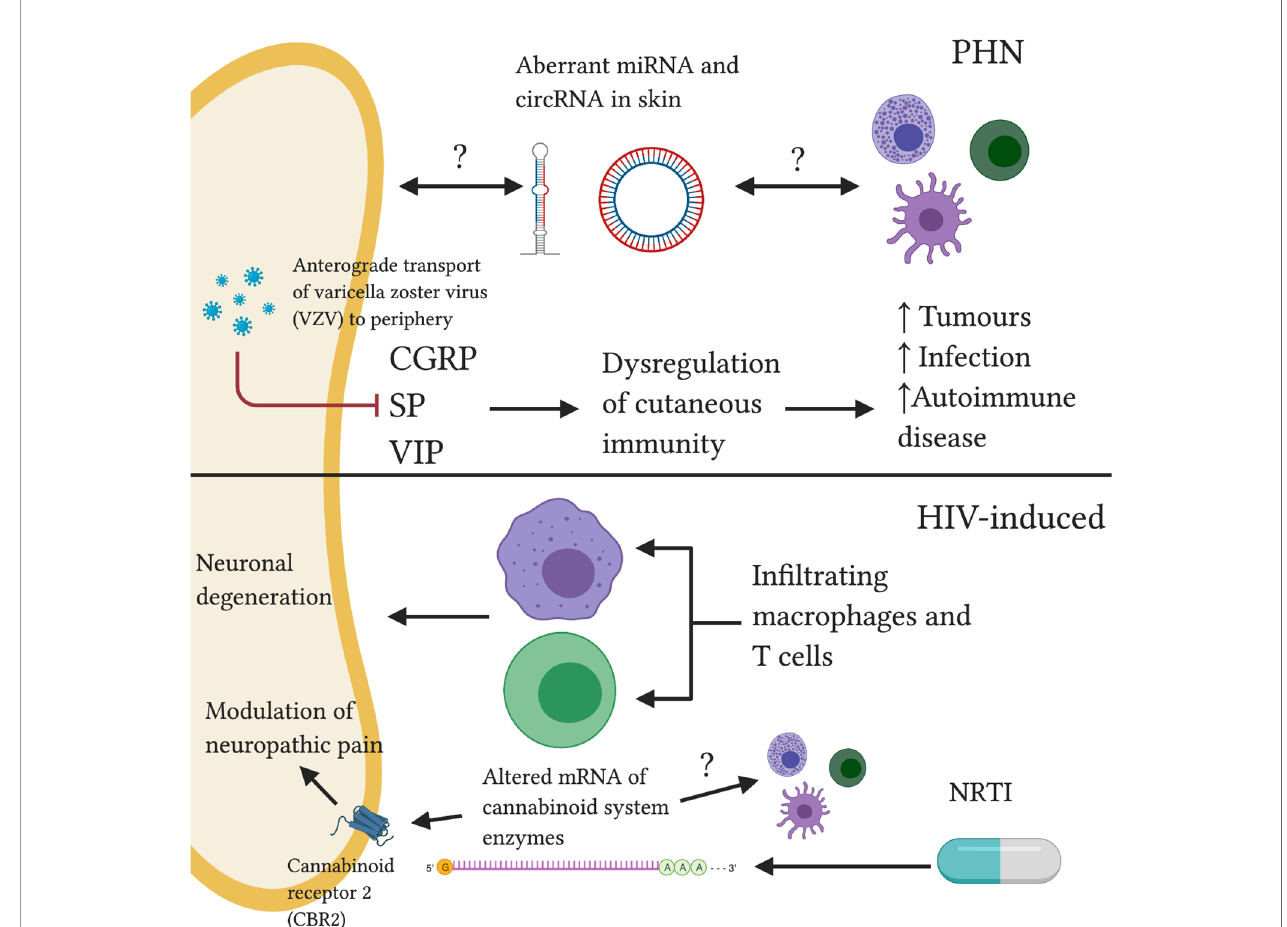
FIGURE 4 | Reported and speculative neuroimmune interactions within the skin in PHN and HIV-induced neuropathy. In PHN, anterograde transport of VSV results in dysregulation of cutaneous neuropeptide (CGRP, SP, VIP) signalling, increasing susceptibility to various pathologies. Altered ncRNA balance may modulate neuronal and immune function. HIV-induced neuropathy is associated with in fi ltrating neurotoxic macrophages and T cells. NRTI treatment drives abnormal cannabinoid system signalling, a system implicated in the pathogenesis of neuropathic